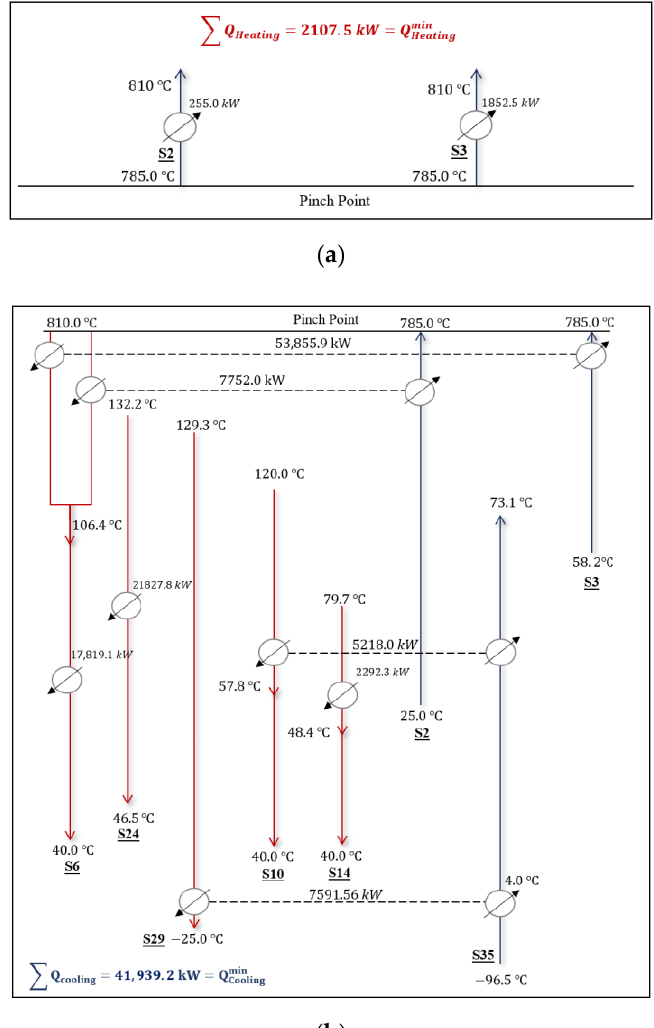
Figure 8. Heat exchanger network ( a ) above the pinch, ( b ) below the pinch.